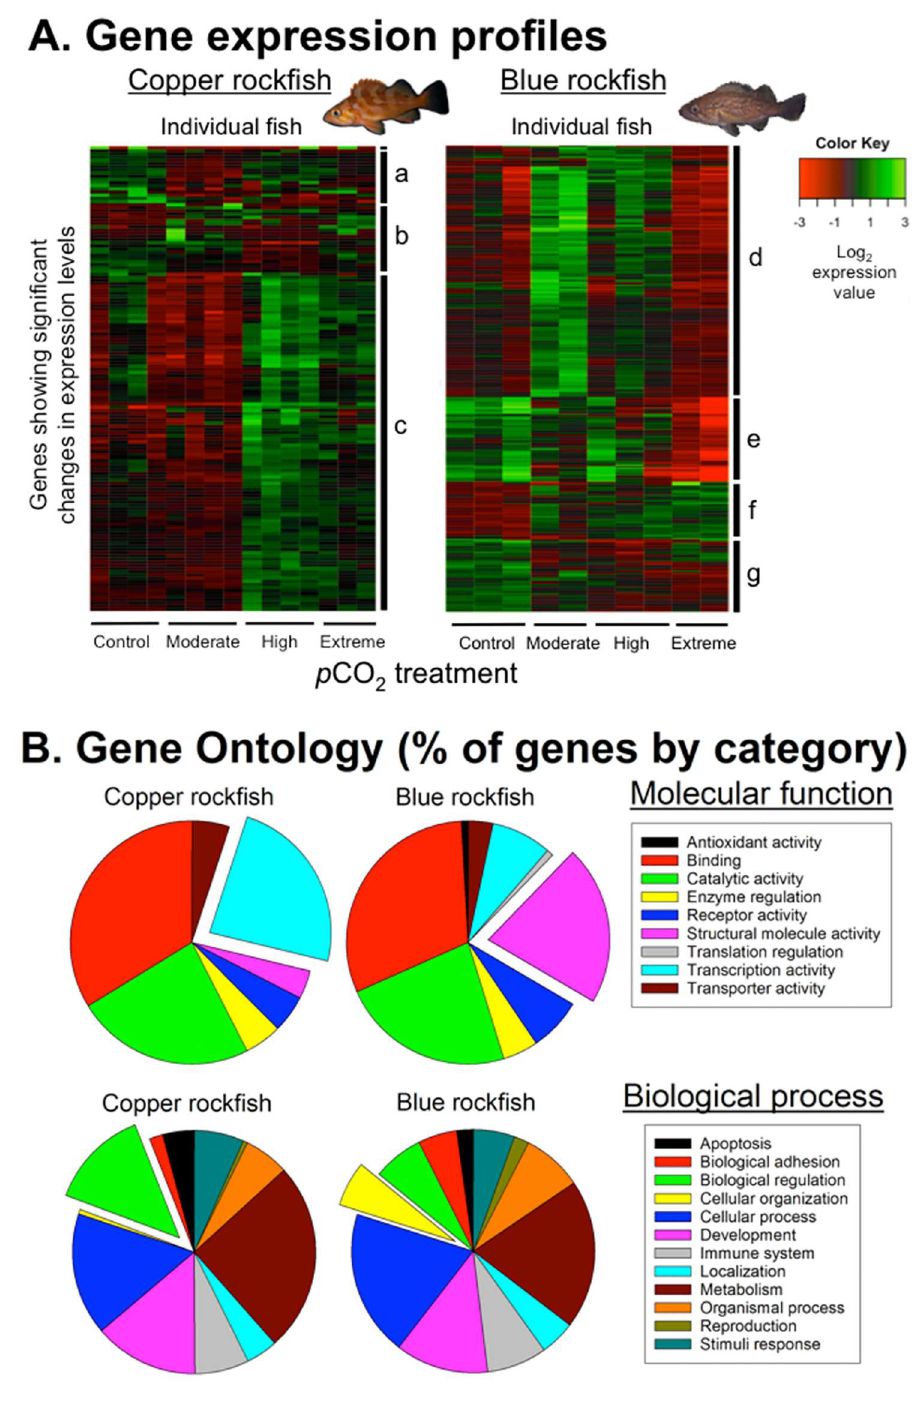
Fig 3. Gene expression profiles (A) and Gene Ontology (GO) functional categories (B) for copper and blue rockfish muscle tissue as a function of p CO 2 treatment. (A) Heatmapsdisplay significantdifferential gene expression(DE) for copper( n = 147) and blue ( n = 358) rockfish (FDR < 0.001) among p CO 2 treatments; green = up-regulation, red = down-regulation.Each column represents an individual fish ( n = 15 copper rockfish and n = 10 blue rockfish). Genes are orderedby similarity in gene expressionprofile and differ in both order and identity betweenthe two species (only 14 DE geneswere in common betweenthe two species). Hierarchical (Euclidean)clusteringwas used to group similar gene expressionprofiles, labeled along the